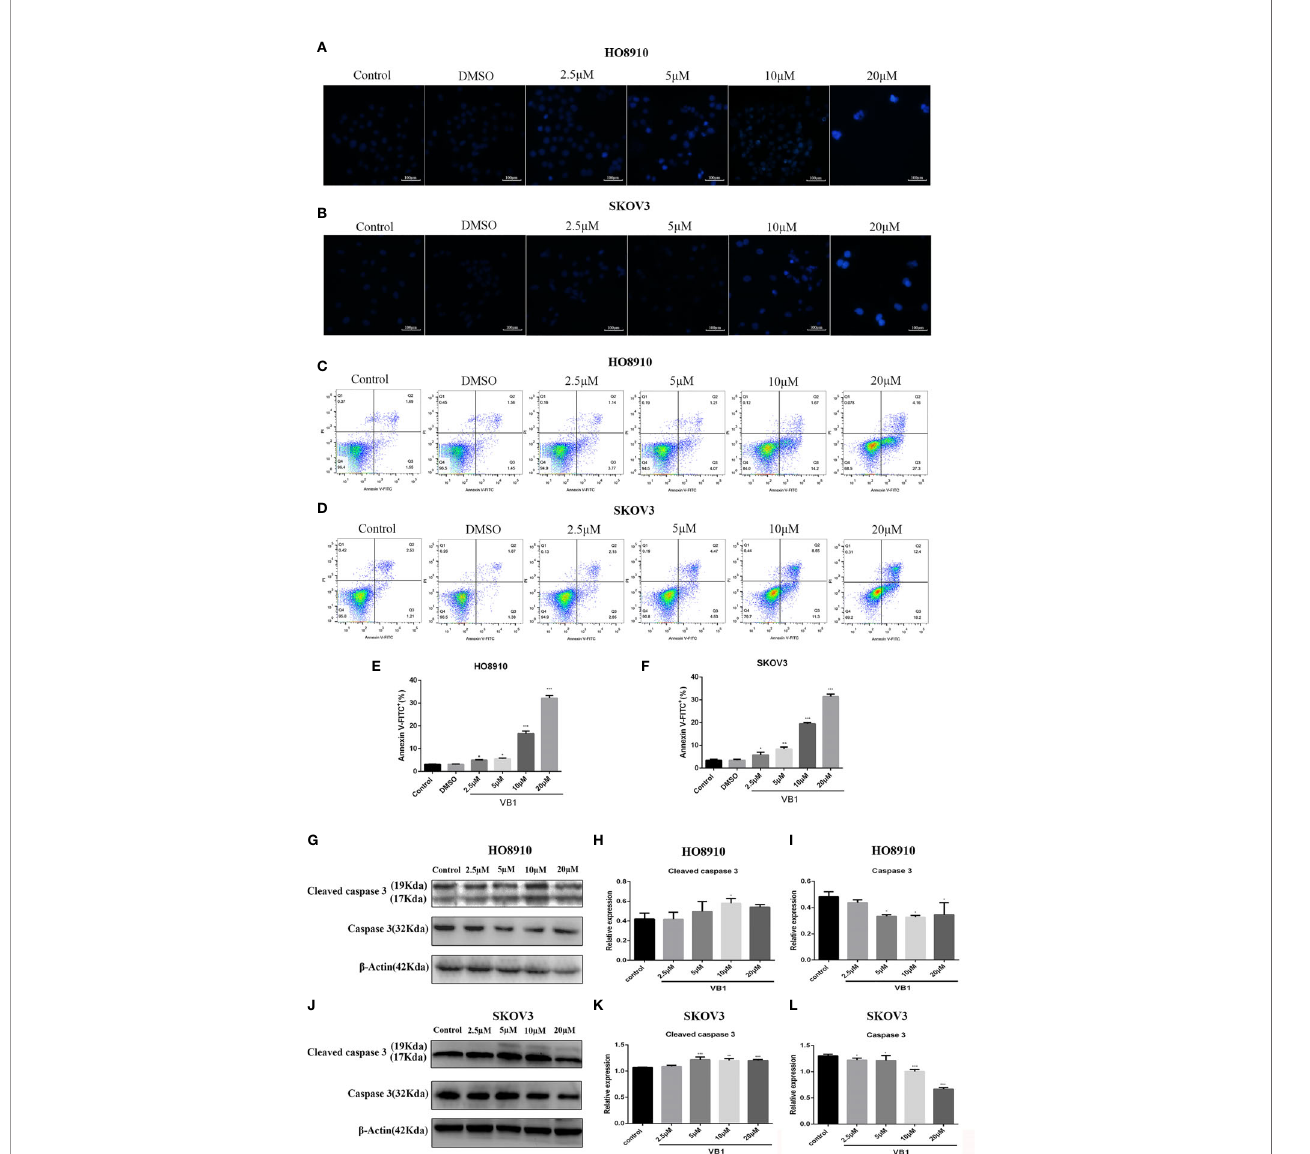
FIGURE 2 | VB1 provoked apoptosis in human ovarian cancer cells with a caspase signaling pathway. (A, B) H08910 cells and SKOV3 cells were exposed to VB1 (0 µM), 0.1% DMSO, or VB1 (2.5 – 20 µM) for 24 h; after 24 h, the treated cells were subjected to Hoechst 33258 staining and apoptotic morphological changes were observed using a microscope (magni fi cation ×100). (C – F) HO8910 cells and SKOV3 cells were handled with VB1 (0 µM), 0.1% DMSO, and VB1 (2.5 – 20 µM) for 24 h; the fl ow cytometry with Annexin V-FITC/PI staining was performed to detect apoptosis. (G – I) HO8910 cells were exposed to VB1 (0-20 µM) for 24 h; the expression of apoptotic protein was determined by Western blotting. (J – L) SKOV3 cells were exposed to VB1 (0 – 20 µM) for 24 h, and the expression of apoptotic protein was determined by Western blotting. Data represent the mean ± SD of three independent experiments. *P < 0.05, **P < 0.01, ***P < 0.001 compared with the control